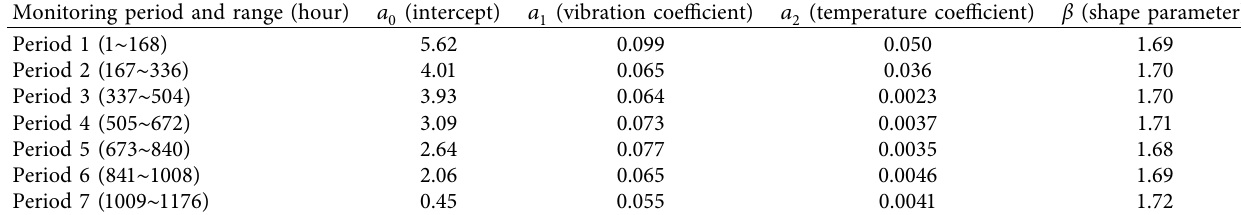
Table 5: GLL-Weibull model parameters of every monitoring period.